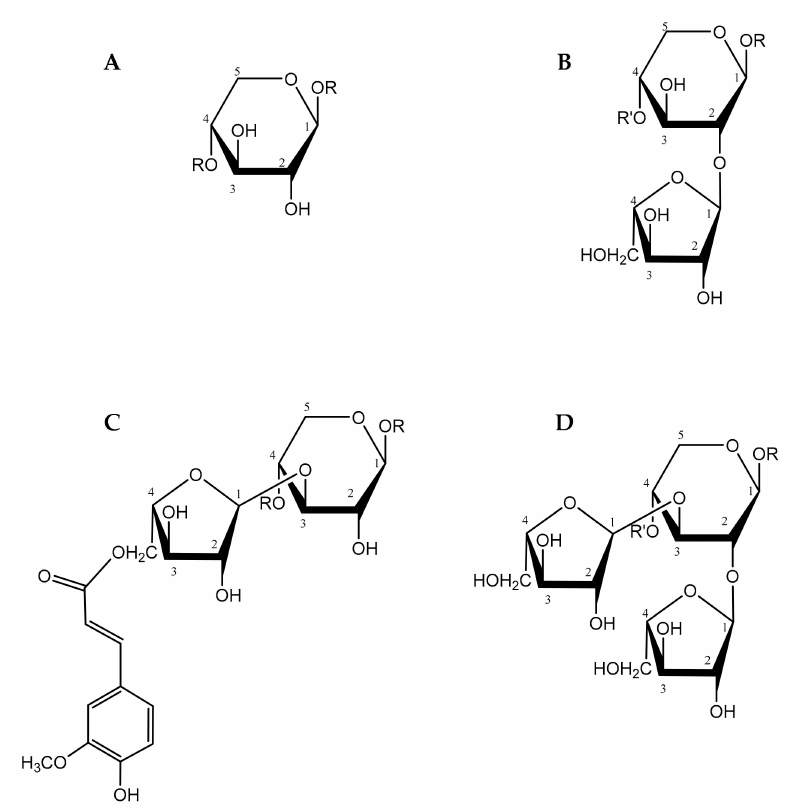
Figure 2. The general building units of arabinoxylan (AX) molecules. ( A ) Unsubstituted xylose unit; ( B ) Xylose residue substituted at C(O)-2 with an arabinose residue; ( C ) Xylose residue substituted at C(O)-3 with an arabinose residue, a ferulic acid moiety esterified to the arabinose at C(O)-5; and ( D ) disubstituted xylose unit at C(O)-2 and C(O)-3 with arabinose